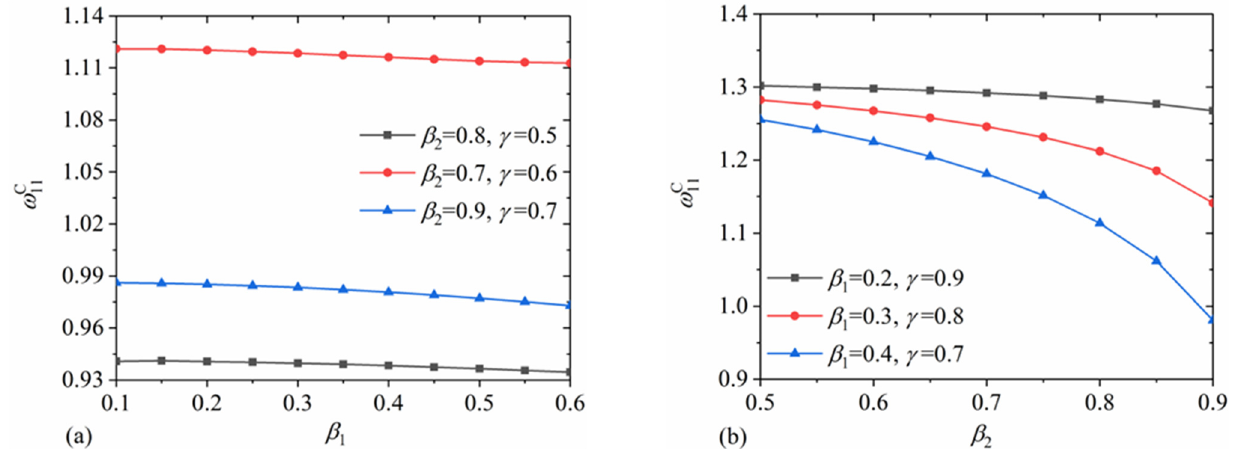
Figure 7. The first-order convective frequency for the baffle height: ( a ) the height of the lower baffle β 1 ; ( b ) the height of the upper baffle β 2 .